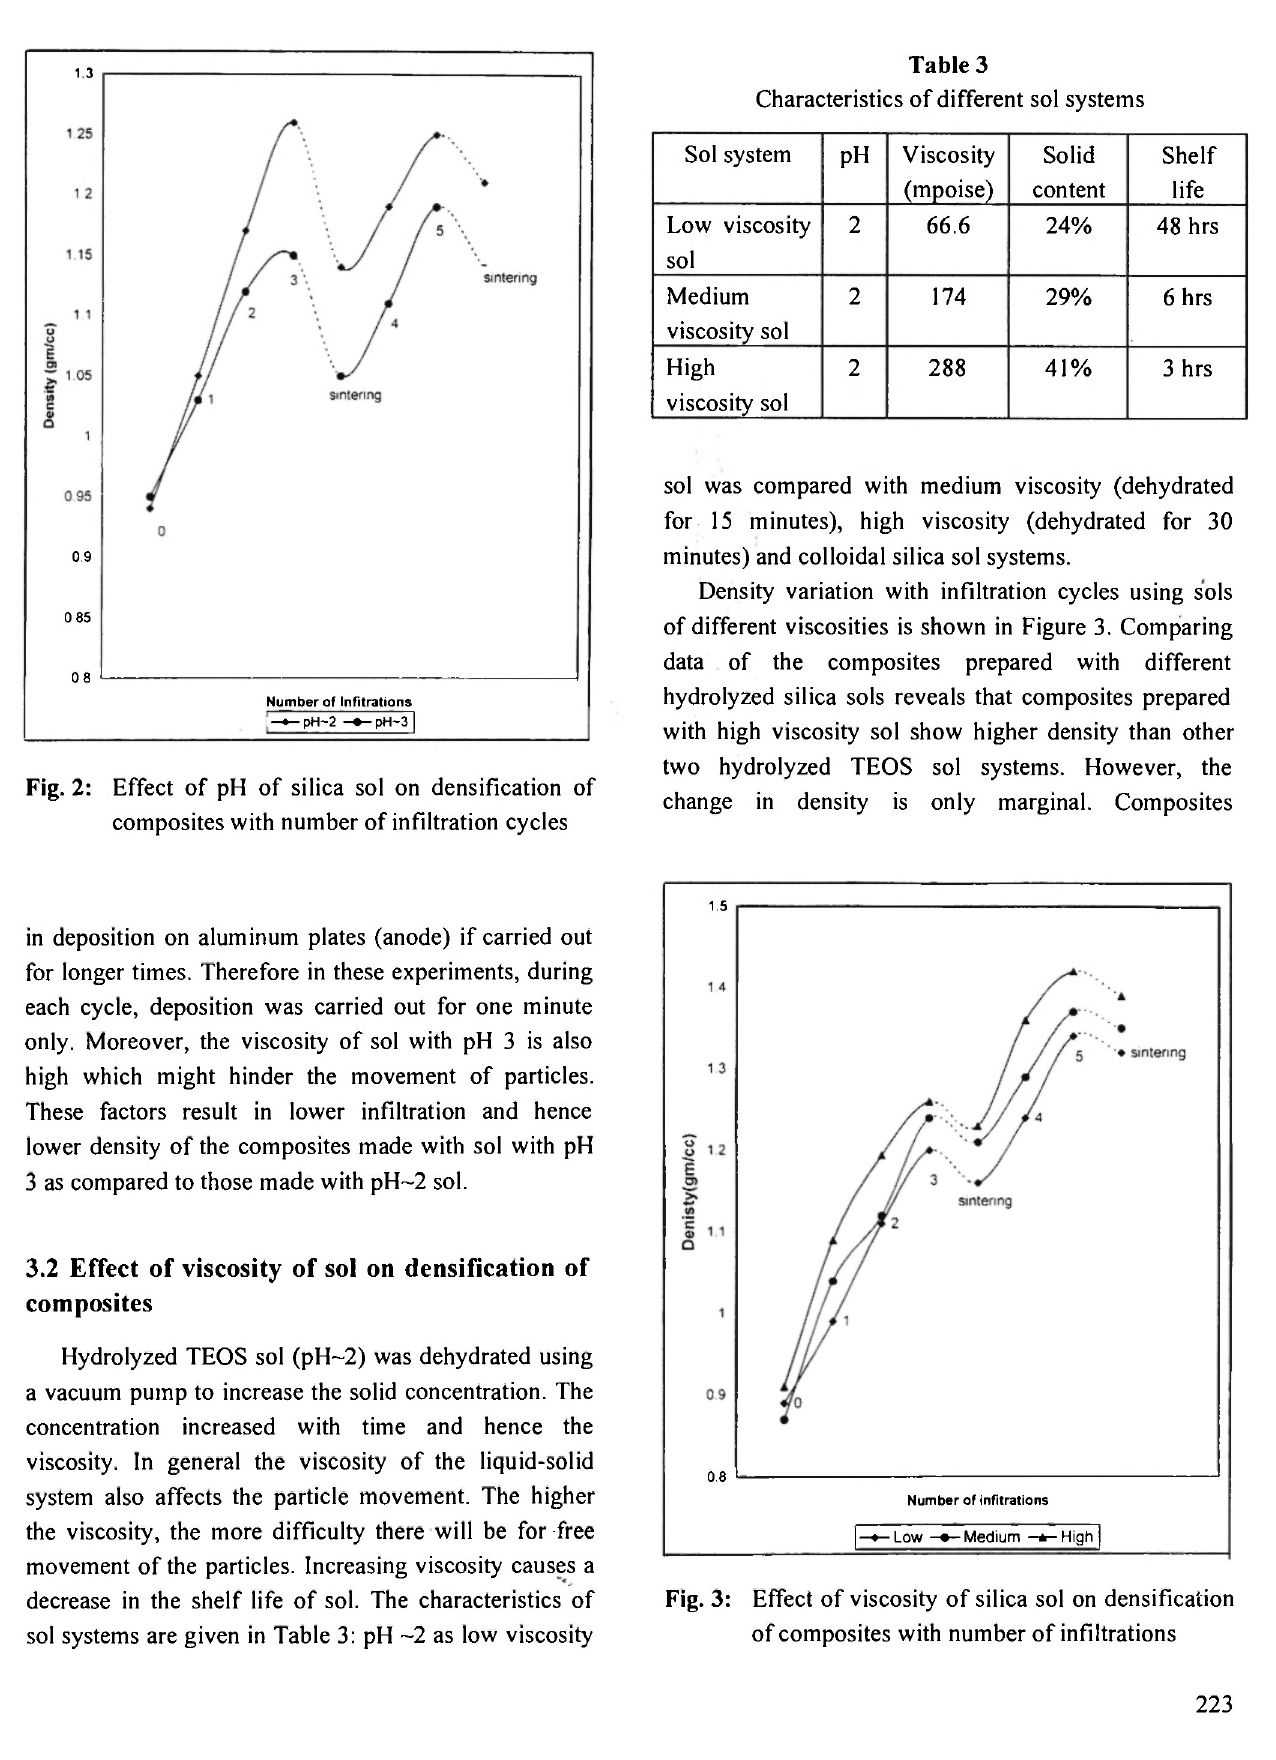
Fig. 3: Effect of viscosity of silica sol on densification of composites with number of